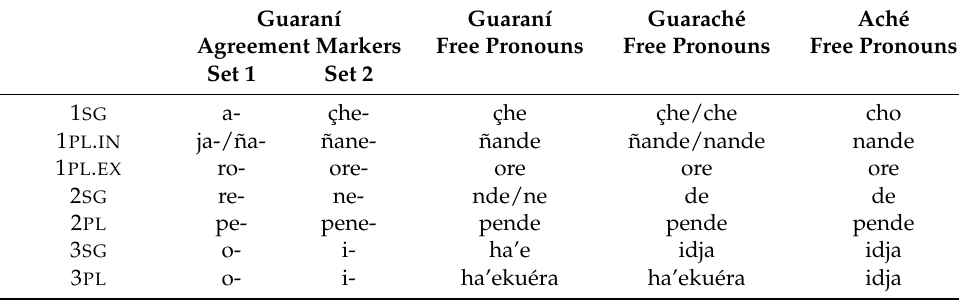
Table 1. Person markers and pronouns in Aché, Guaraní, and Guaraché.